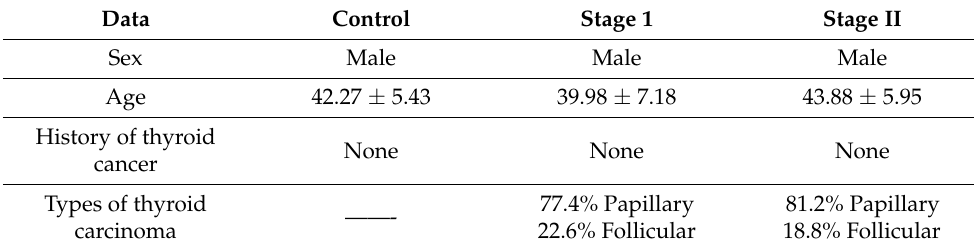
Table 2. Data and clinical characteristics of all subjects in the